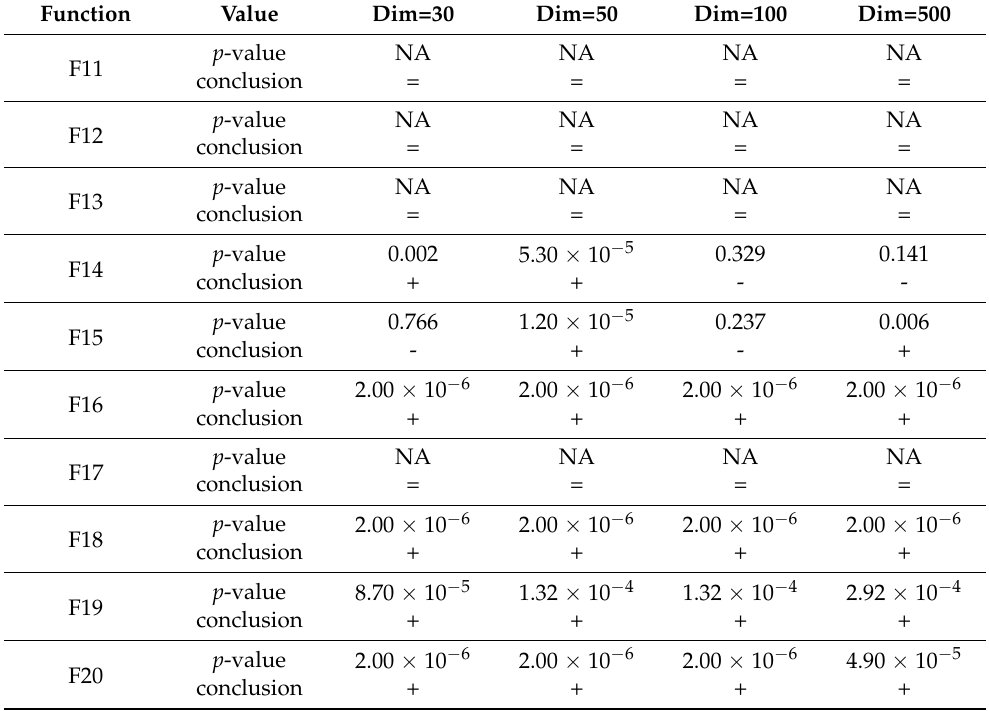
Table 11. Statistical results of Wilcoxon signed-rank test on multimodal functions.